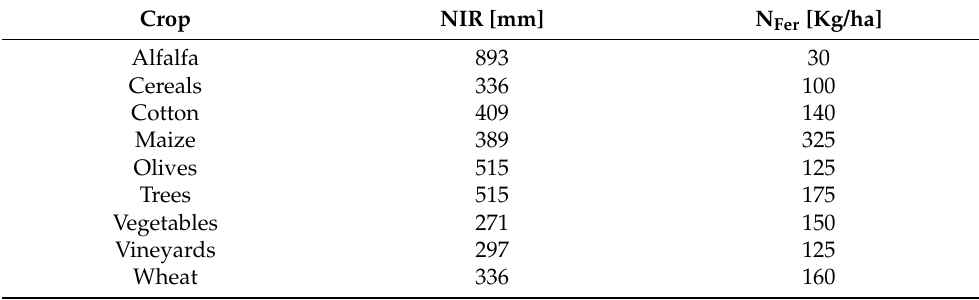
Table 8. Maximum annual Near Irrigation Requirement (NIR) and typical nitrogen fertilizer loading.